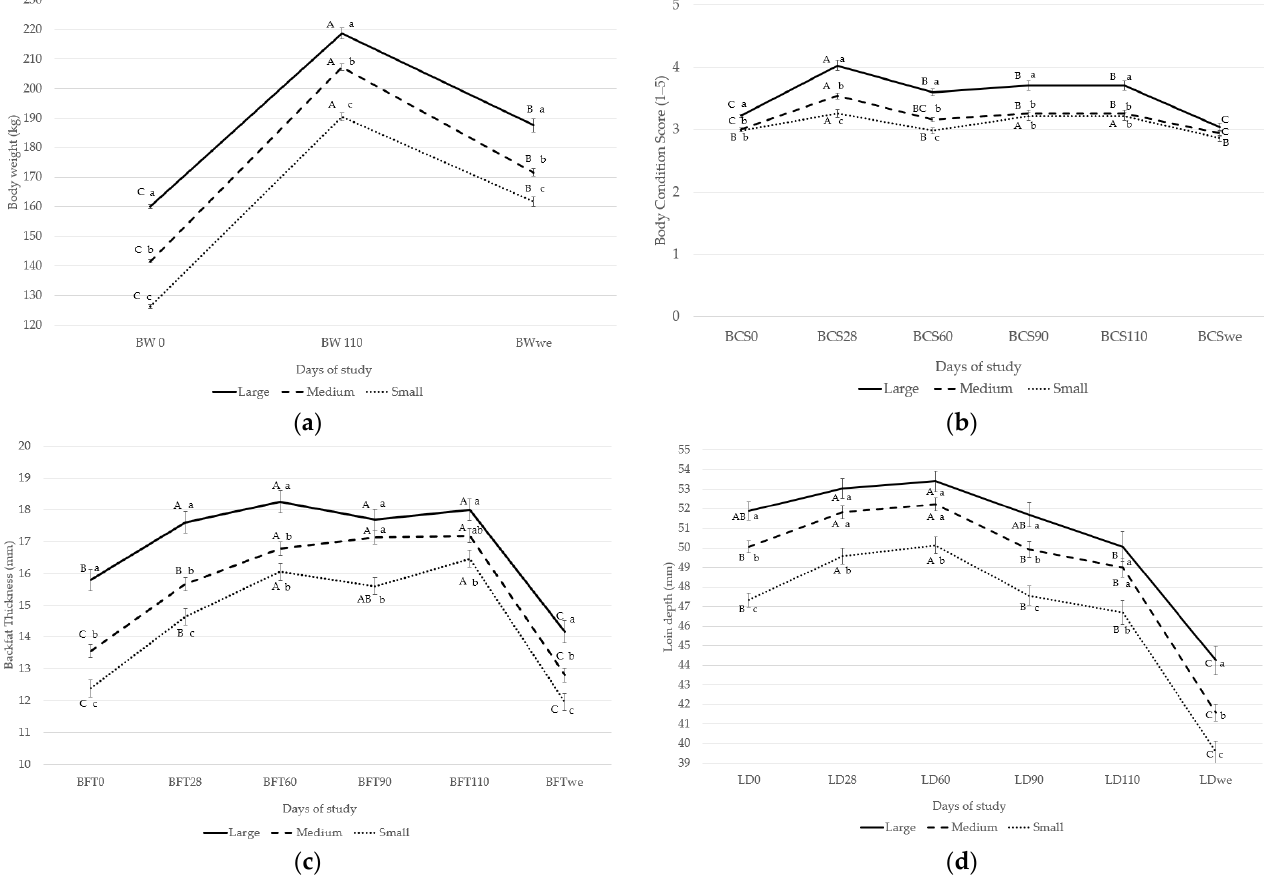
Figure 1. Effect of body weight of gilts at first service on evolution of ( a ) body weight (BW), ( b ) body condition score (BCS), ( c ) backfat thickness (BFT), and ( d ) loin depth (LD) during first parity and at weaning (we). The BCS was evaluated using an increasing ordinal scale from 1 (very thin) to 5 (very fat) according to Bonde et al. [24]. Lowercase letters represent differences between groups at each time point. Capital letters represent within-group differences over time. Weight group at first service: (1) Large sow (>150 kg BW; n = 63); (2) Medium sow (135–150 kg BW; n = 155); (3) Small sow (<135 kg BW; n = 108).